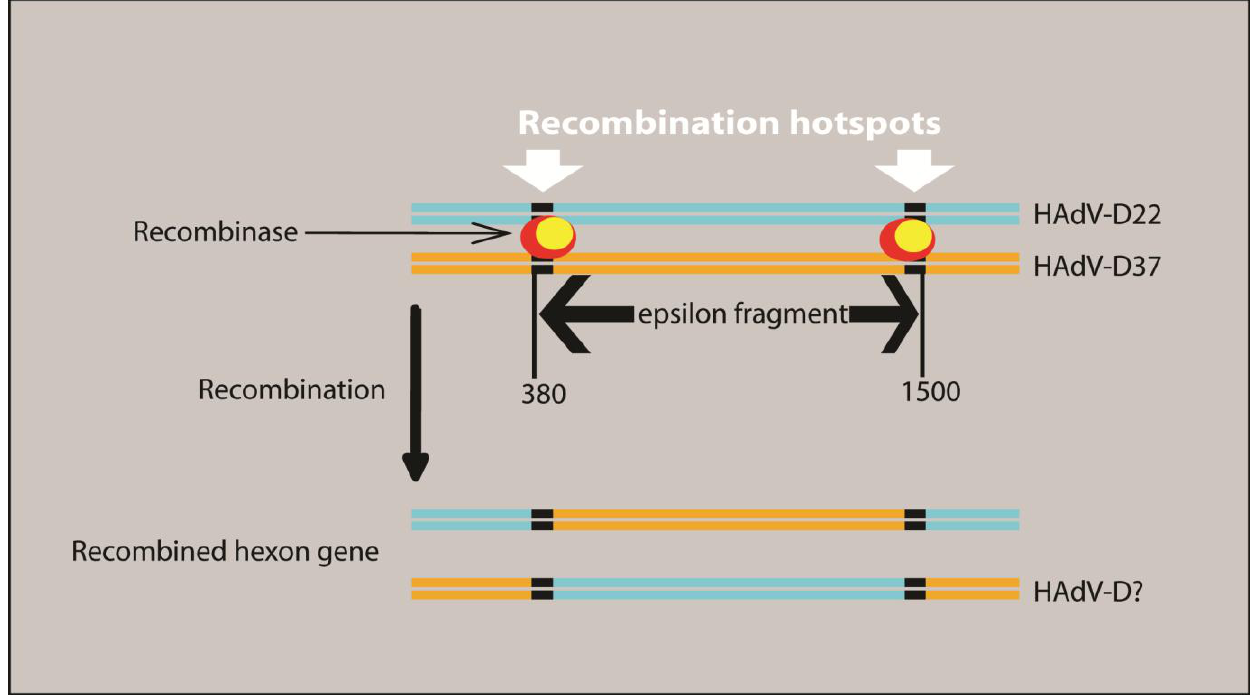
Figure 3. Model of recombination for human adenoviruses. Recombination in the hexon gene of HAdVs is hypothesized to occur around nucleotide positions 380 and 1500. These positions frame the neutralization determinants (epsilon  fragment) of HAdVs. These positions are also demarcated by white arrows. The indicated nucleotide positions are based on HAdV-D53